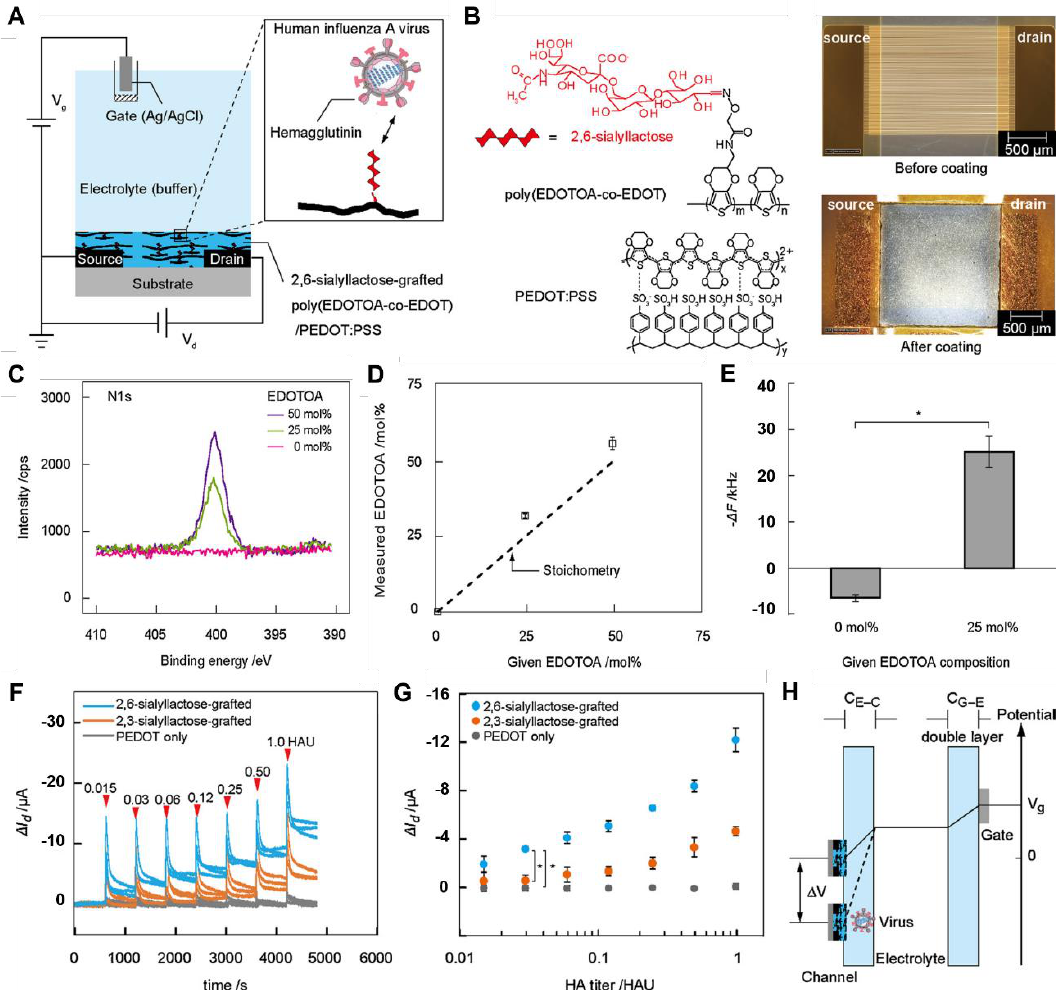
Figure 11. Scheme of the functionalized OECT ( A ). Chemical structures of 2,6-sialyllactose-grafted poly(EDOTOA-co-EDOT) and PEDOT:PSS and optical micrographs of the interdigitating microelectrodes before and after the coating of a PEDOT:PSS film ( B ). High-resolution XPS spectra of N1 s films at different compositions of EDOTOA during the electrodeposition on a PEDOT:PSS film ( C ). Given and measured compositions of EDOTOA on the surface of the electrodeposited film ( D ) Changes in the QCM frequencies before and after the reaction with 2,6-sialyllactose of PEDOT:PSS and poly(EDOTOA-co-EDOT)/PEDOT:PSS films at 25 mol% EDOTOA ( E ). Adapted with permission from reference [119]. Copyright 2020